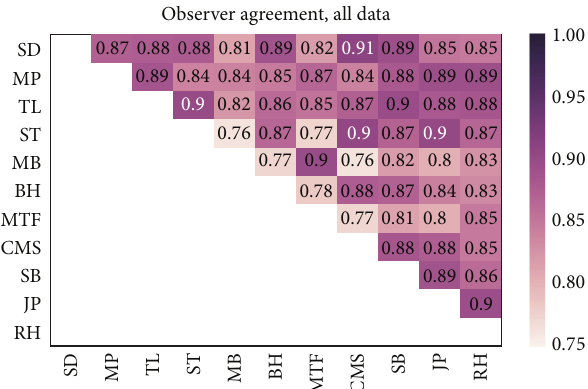
Figure2:Theagreement, 𝑃 cutouts.